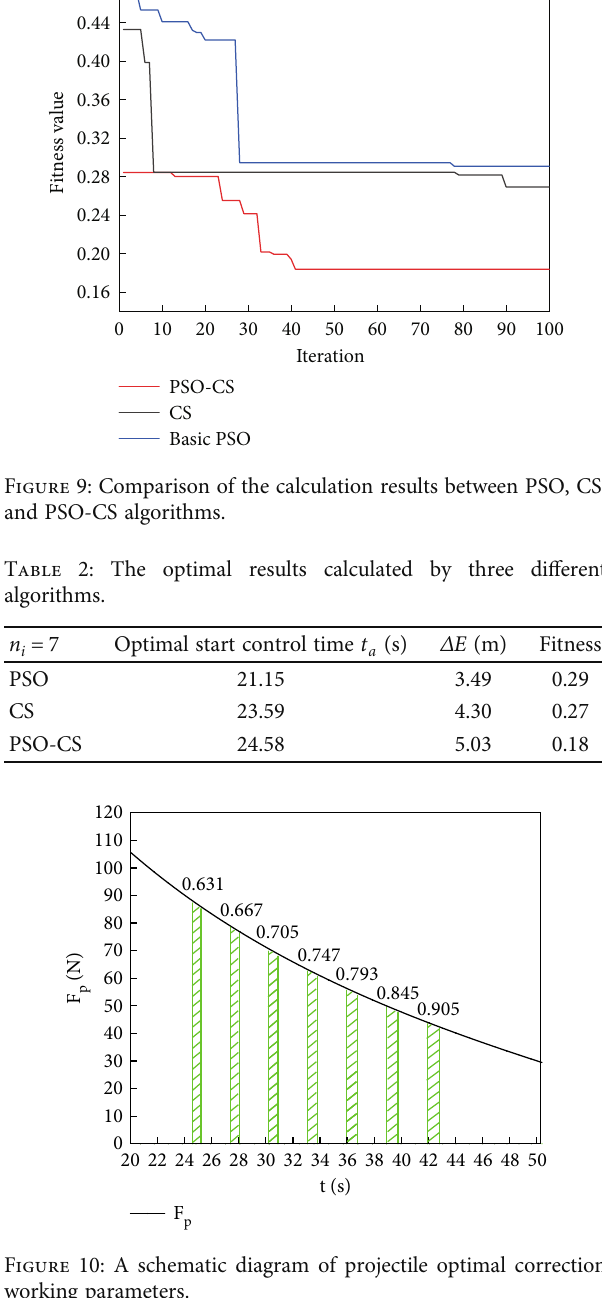
Table 3: The correction working parameters in the scheme.